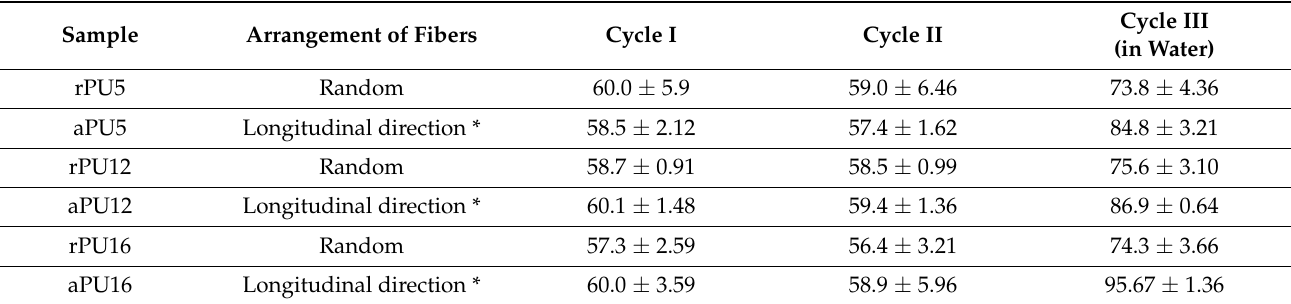
Figure 7. The flow of the programming process registered on DMA for rPU16 mat. Table 5. Values of recovery rate (R r